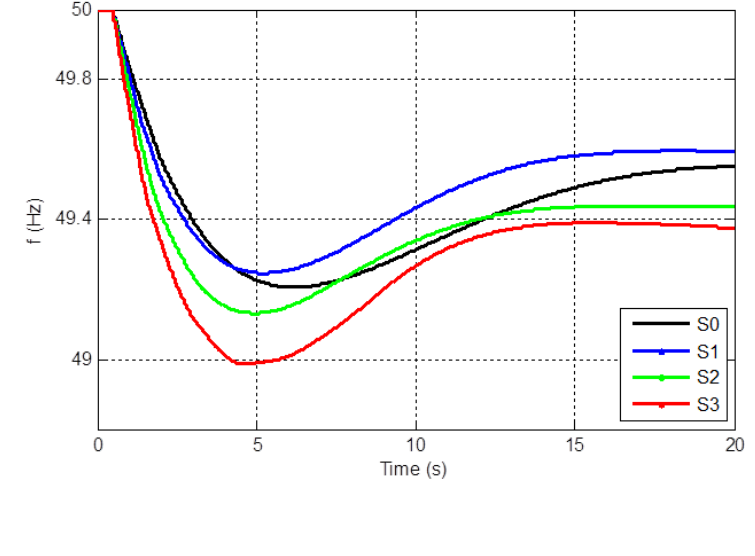
Figure 6. Frequency response with PV-PPs providing FFR, 3% deload